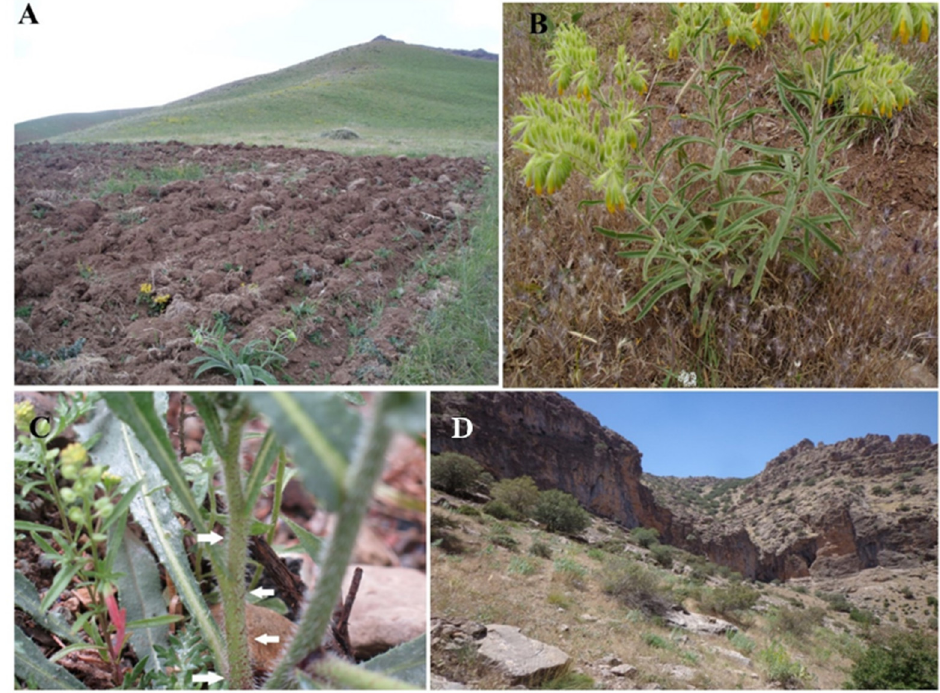
Figure 4. ( A ) Habitat of Onosma nervosa Riedl in Divandarreh ( B ) O. nervosa Riedl, ( C ) Anchusa azurea Mill. with purplish to black spots in stem ( D ) Habitat of Onosma nervosa Riedl in Shaho, Ravansar.